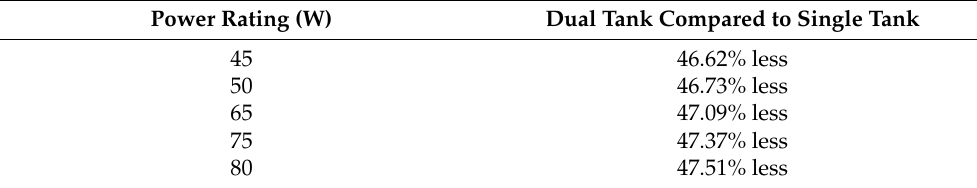
Table 3. Dual tank compared to single